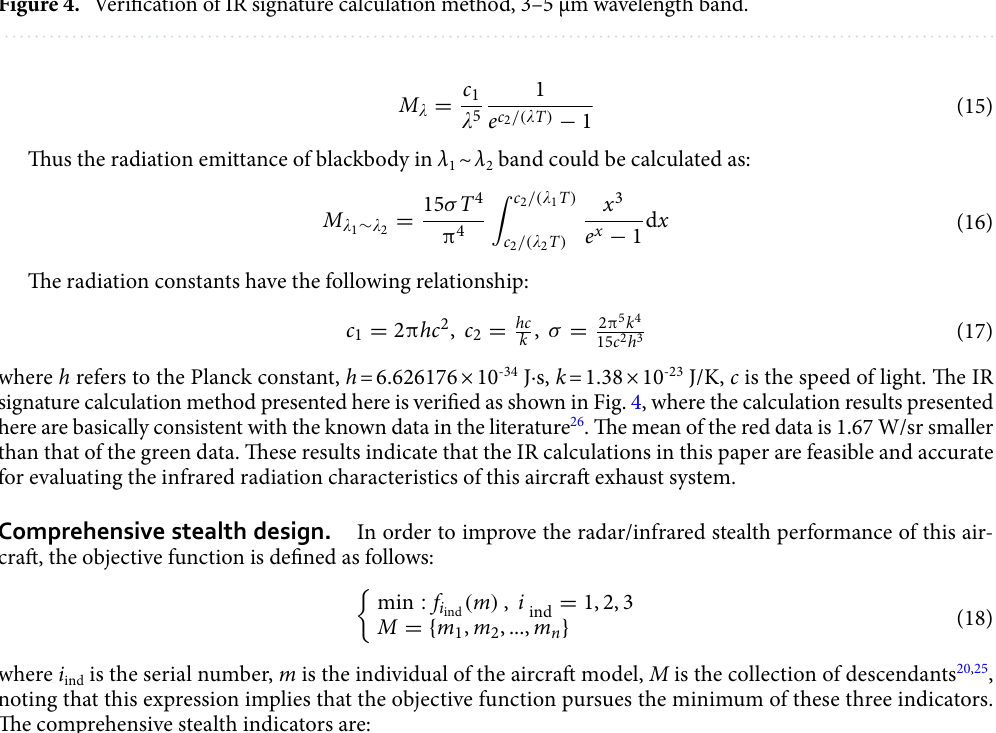
Figure 4. Verification of IR signature calculation method, 3–5 μm wavelength